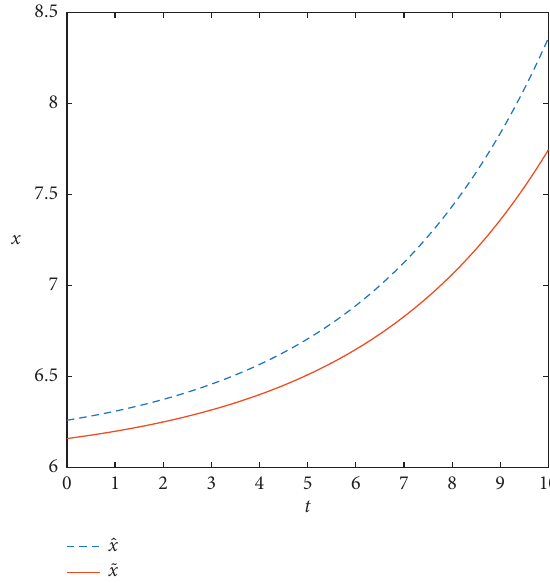
Figure 14: The pollution stock trajectory of the upstream region under cooperation.